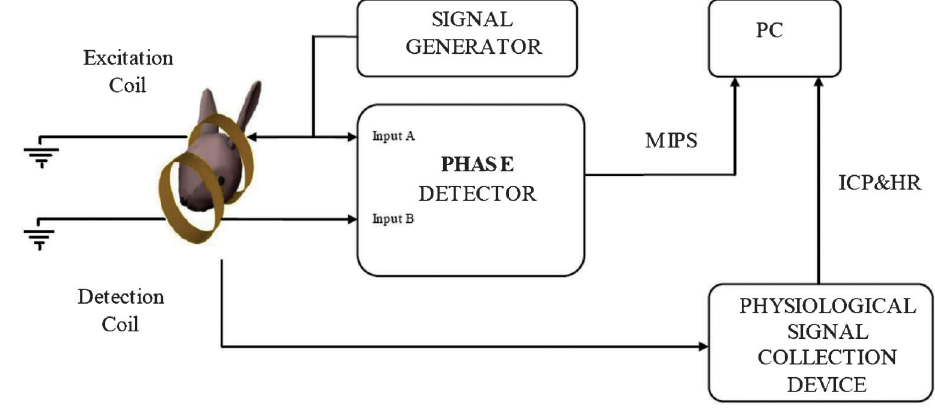
Figure 2. System block diagram of the magnetic induction phase shift (MIPS) detection method. Data from rabbits were obtained with a physiological signal collection device. Intracranial pressure (ICP), heart rate (HR), and MIPS were synchronously collected to compare the measured